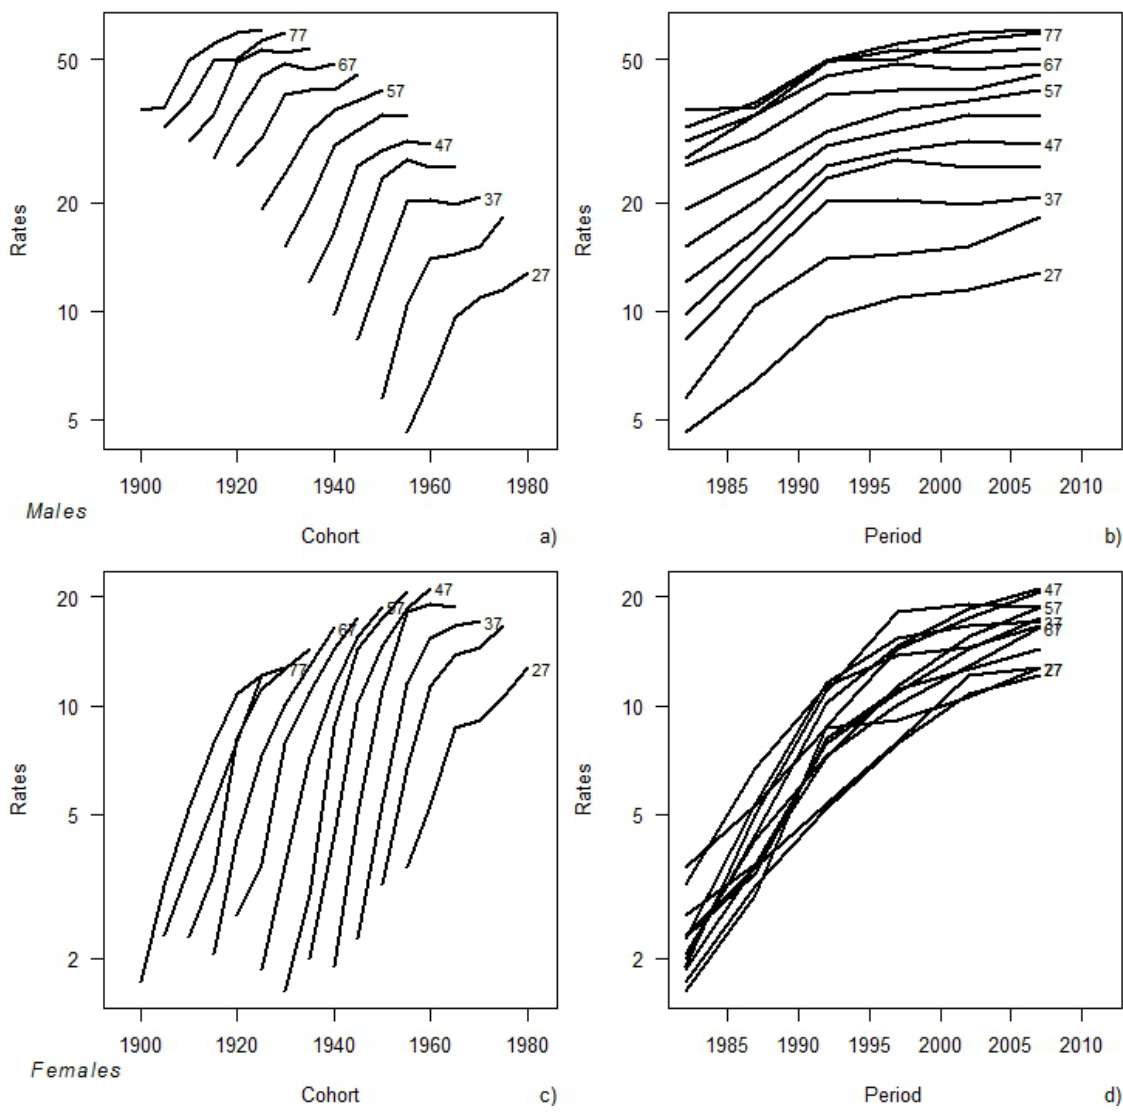
Figure 1. Age-specific prevalence of former smokers ( a ) by birth cohort and ( b ) by time period in males. Age-specific prevalence of former smokers ( c ) by birth cohort and ( d ) by time period in females.